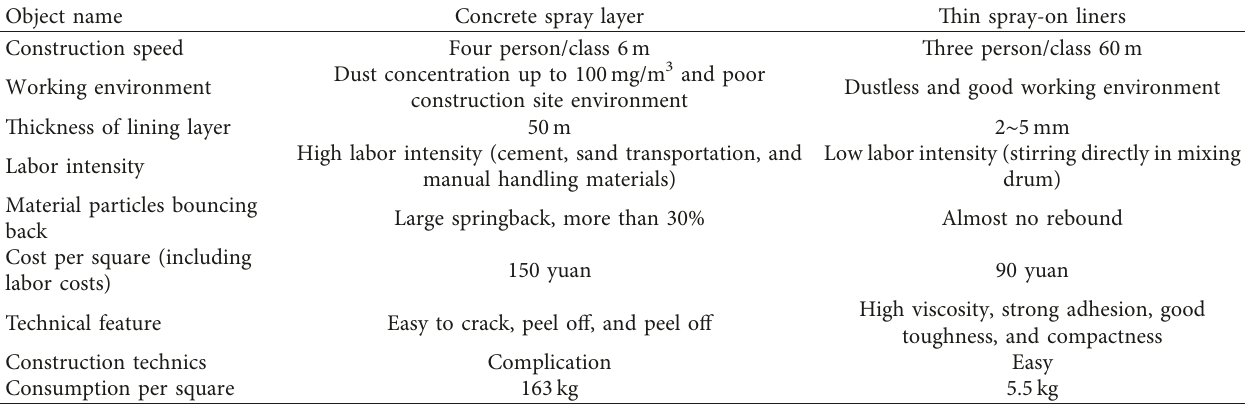
Table 1: Comparison of economic and social benefits of sprayed concrete and the use of thin spray-on liners. Object